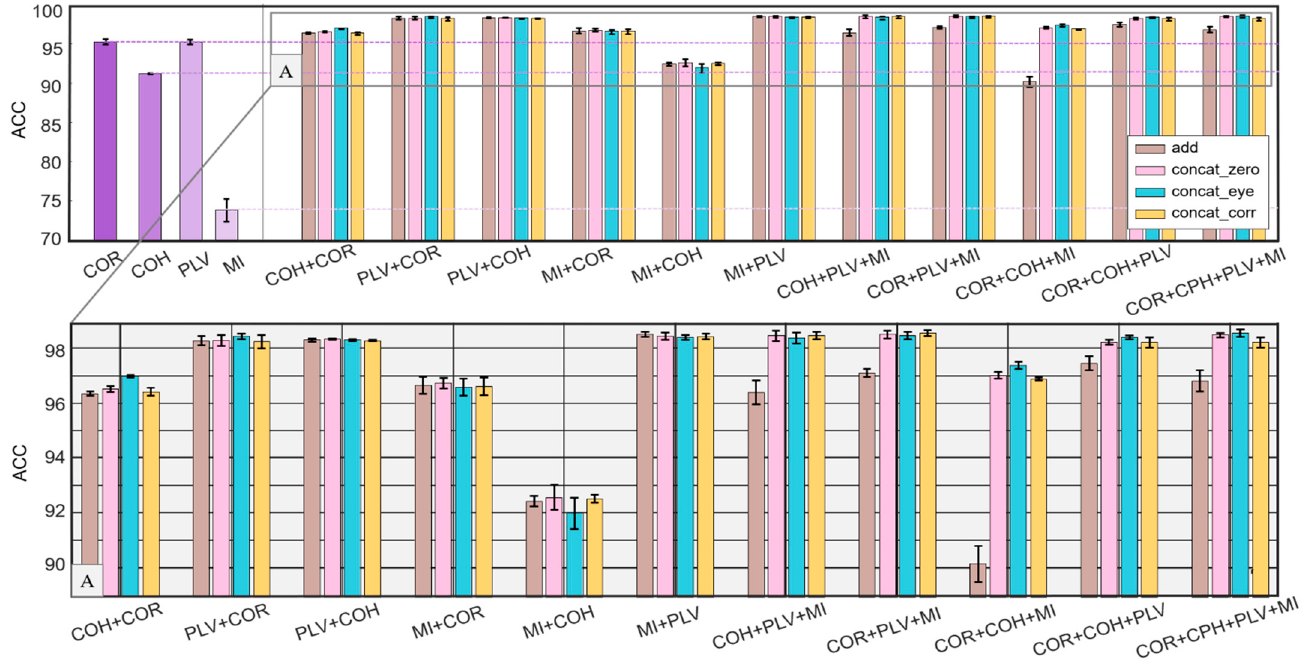
Table 3. Classification accuracy by combining multiple FCs with different fusion methods.